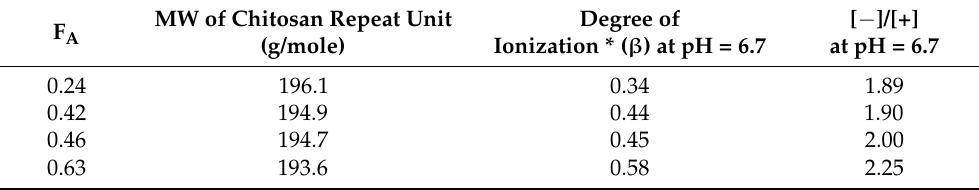
Table 2. Charge ratio, [ − ]/[+], of carboxyl groups of HA to amine groups of CHI at different degrees of acetylation (F A ). MW of Chitosan Repeat Unit Degree of F A (g/mole) Ionization * ( β ) at pH =